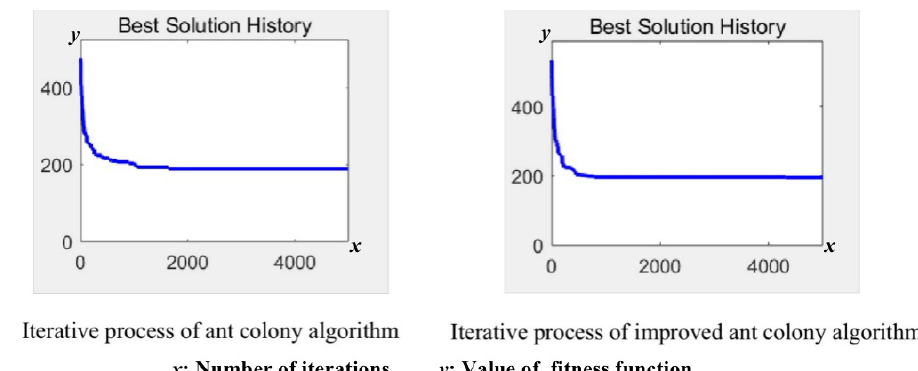
Figure 6. Task assignment iterative process.